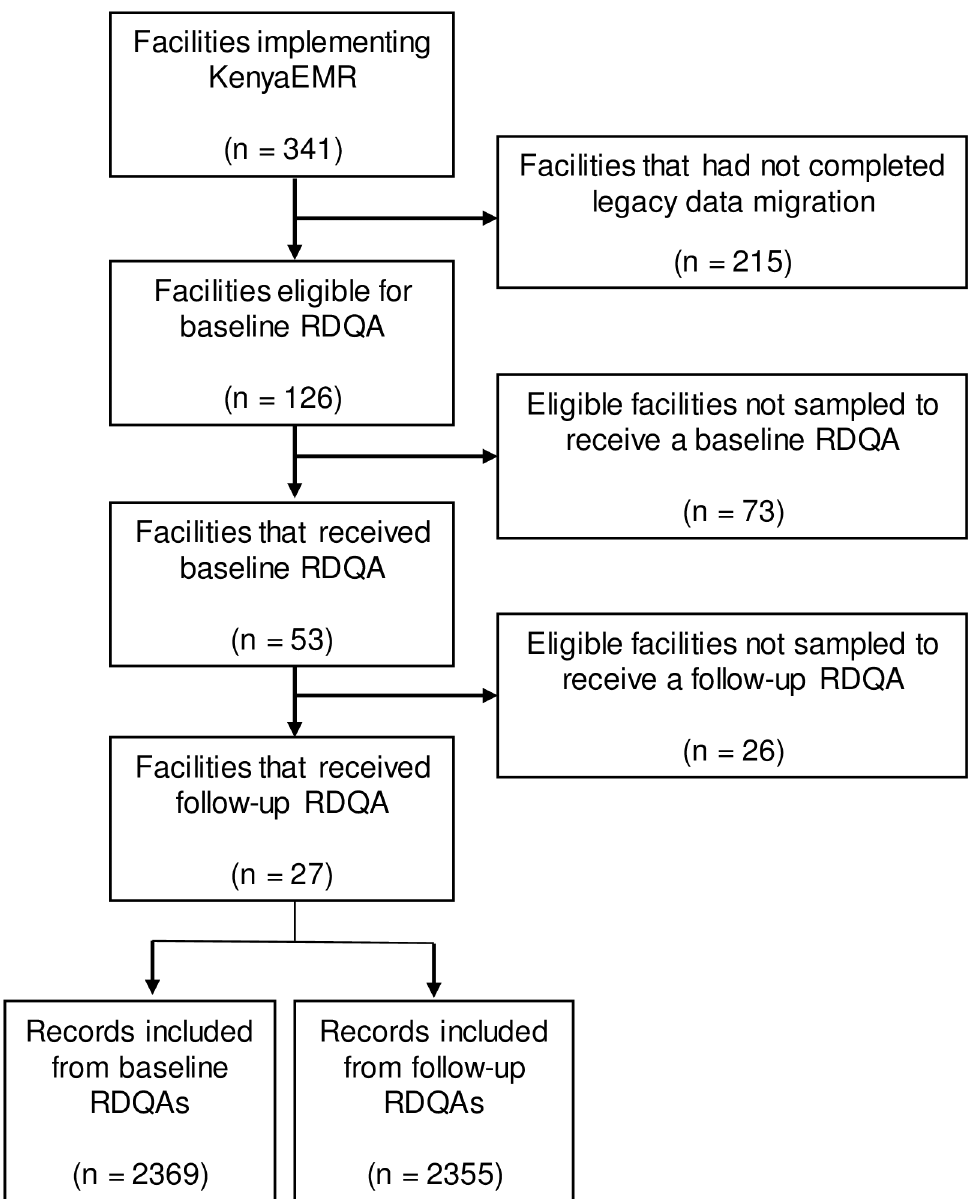
Fig 1. Flow diagram of facility selection for RDQA. RDQAs analysis included 27 facilities out 341 facilities implementing KenyaEMR.